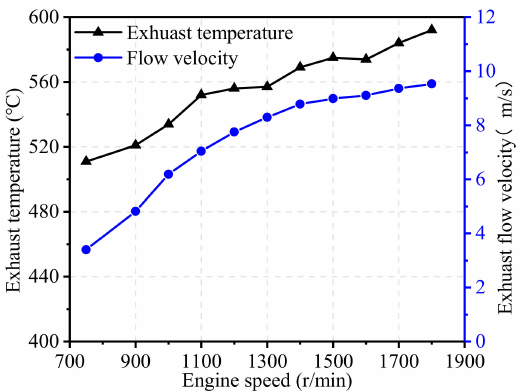
Figure 8. E ff ect of engine speed on exhaust temperature and flow velocity.